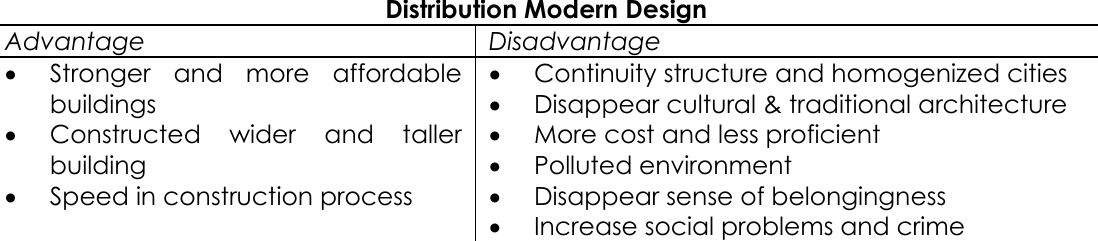
Table 1. The advantage and disadvantage of Modern